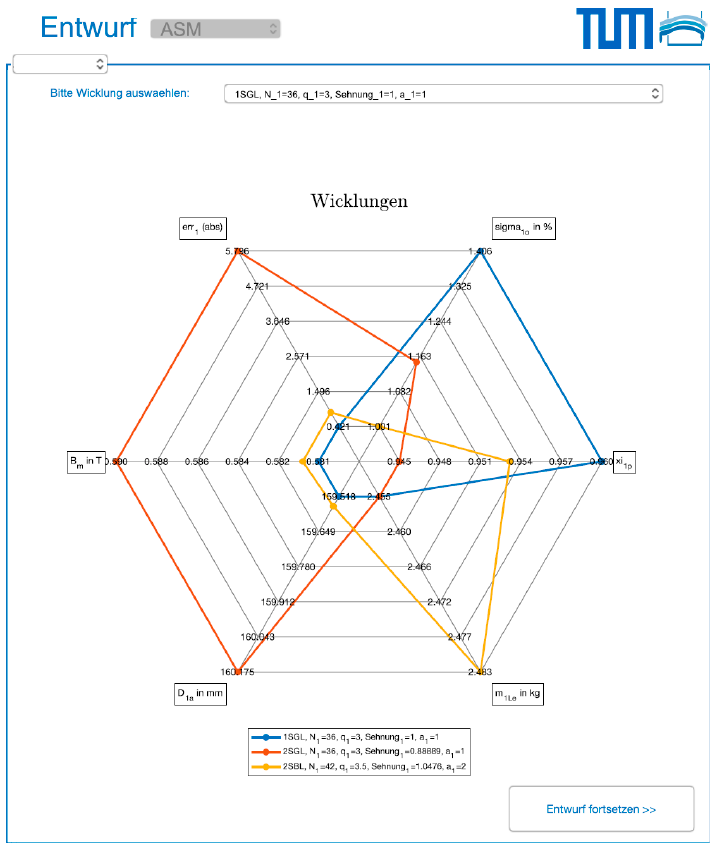
Figure 7. Option Optimization—Comparison of windings according to certain criteria.